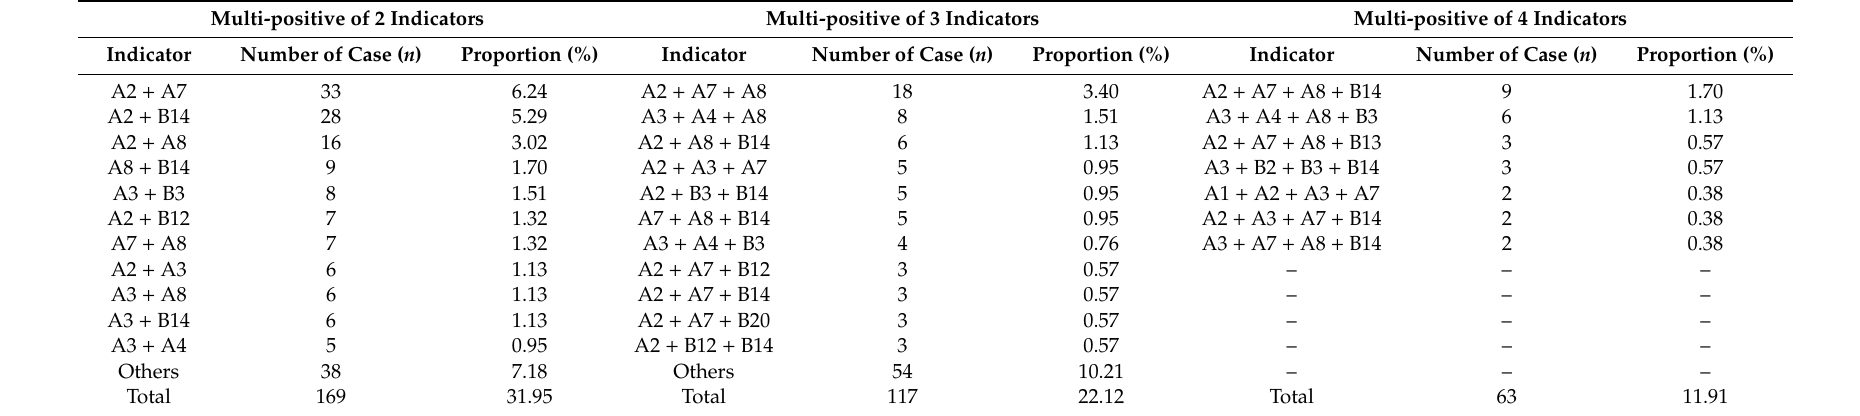
Table 3. Multi-positive frequencies of the indicators in the sample